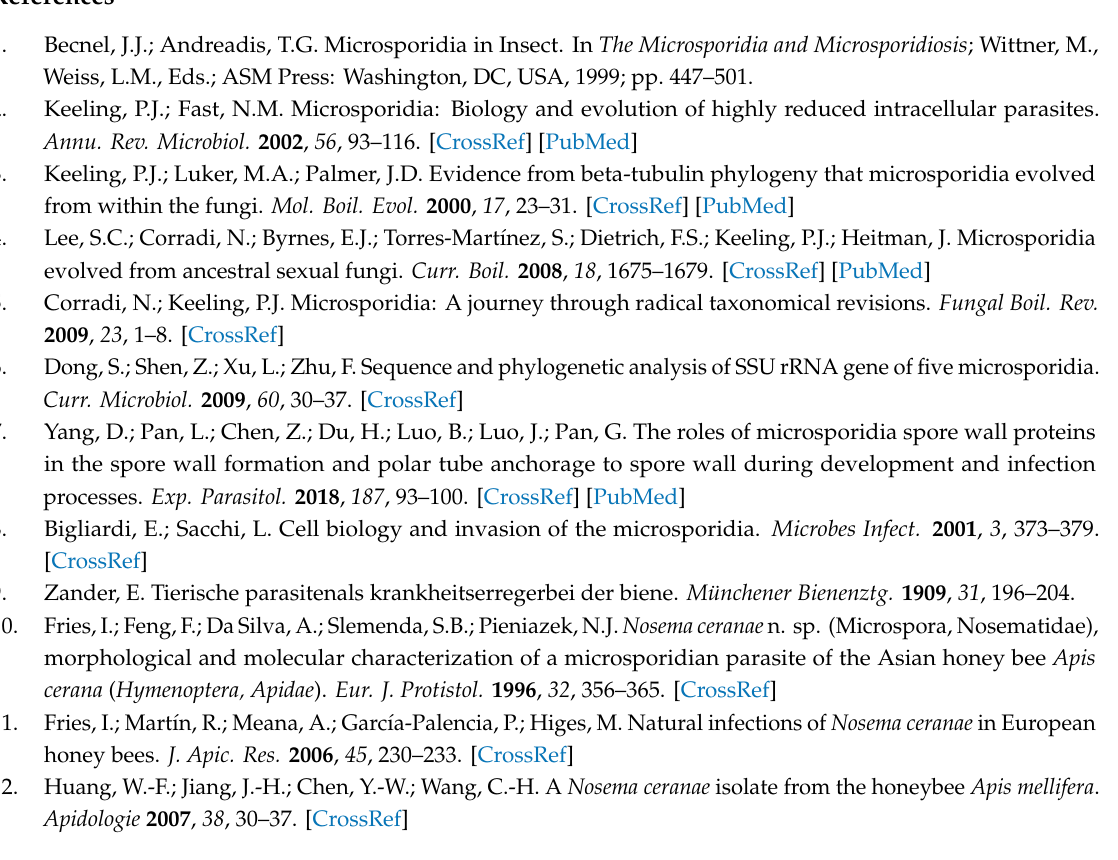
Table S1: Number of Nosema spores in honeybee intestines. The quantification analysis was performed using confocal microscopic images after CFW intestinal staining, Figure S1: Spectra of the PP[Lys(TFA)-Lys(TFA)-OH] 2 , Figure S2: Agarose gels (2%) showing PCR products amplified from Nosema ceranae DNA extracted from spores isolated from Nosema -infected honeybees collected from the experimental apiary of the University of Life Sciences in